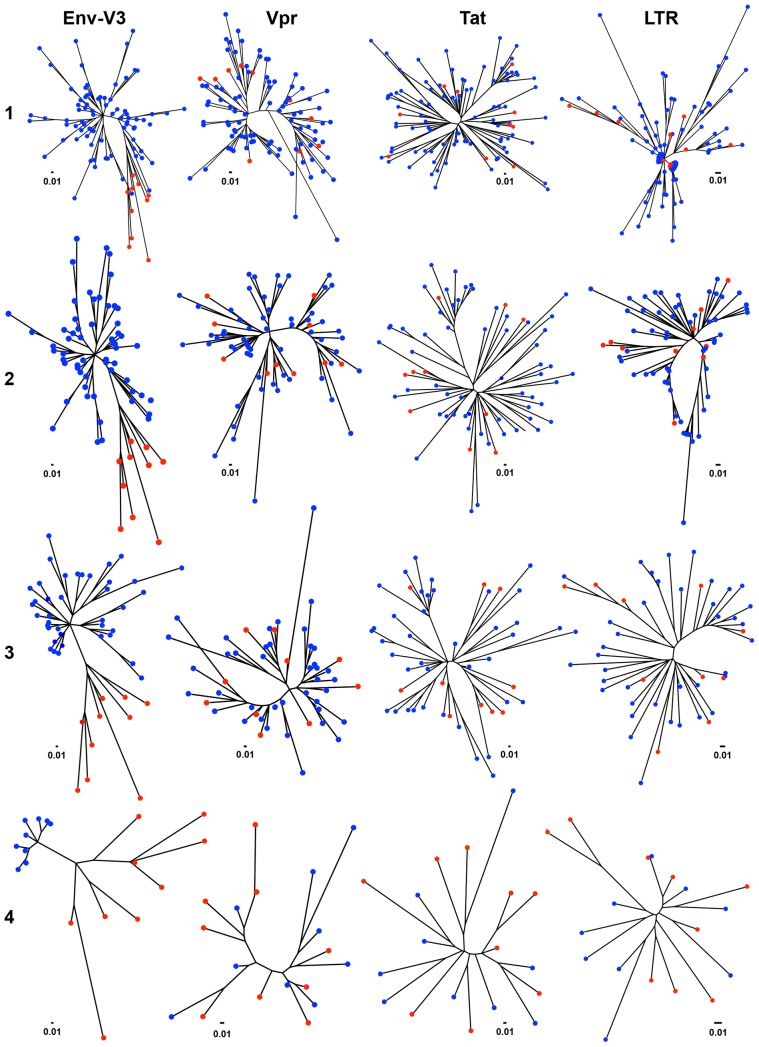
Serial phylogenetic tree constructions of HIV-1 Env-V3, Vpr, Tat, and LTR sequences.Sequences were derived from Drexel Medicine (DM) and LANL. The phylogenetic trees of Env-V3, Vpr, Tat, and LTR sequences were constructed based on a total of 103 combined sequences derived from both LANL and DM, utilizing MEGA5 software. Initially, all comparisons were determined with a total of 87 R5 and only 10 X4 that exhibited a high maximum likelihood (MLHI) (panel 1); subsequent trees were constructed based on a total of 10 MLHI X4 viruses, and numbers of R5 sequences available after certain criteria of elimination (panels 2−4). The blue circles represent the predicted R5 and the red circles the predicted X4 virus.